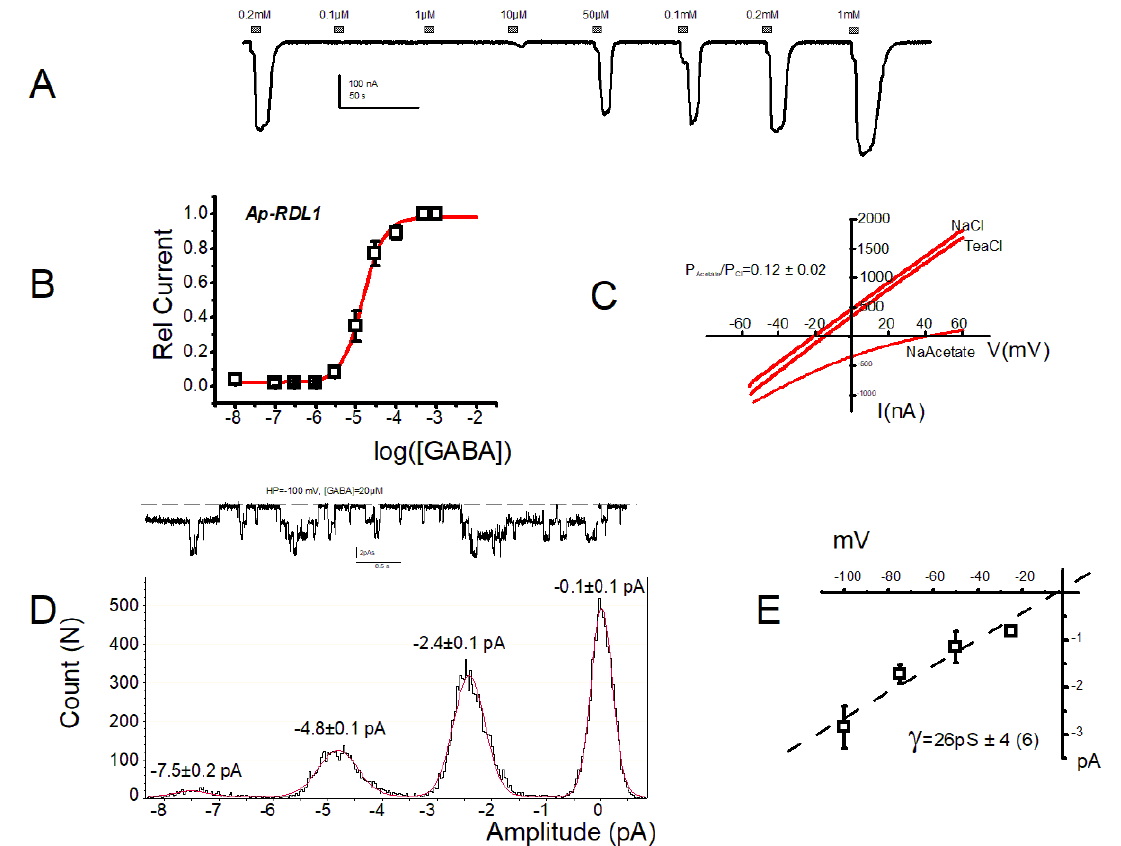
Figure 2. Biophysical characterization of the ( Ap -RDL1 receptor expressed in X laevis oocytes. ( A ) Current trace showing the response of Ap -RDL1 to increasing concentrations of GABA from 0.1 µM to 1 mM at a membrane potential of − 60 mV. ( B ) Full dose – response curve of Ap -RDL1 for GABA. The smooth line represents the best fit to a logistic function. See Table 1 for EC 50 and p values. ( C ) Representative current traces showing the response of the Ap -RDL1 to voltage ramps from − 60 to +60 mV in NaCl, TEACl or Na acetate solutions. The calculated relative permeability Pacetate/Pchloride was 0.12 ± 0.02, n = 6. ( D-top ) Single-channel traces recorded in cell-attached patches of oocytes expressing the RDL1 GABAr subunit. The pipette solution contained ND and GABA at 100 µM, and the external solution was OSO-100 (see methods). Note the presence of (at least) 3 channels under the patch. ( D - bottom ) The amplitude histogram of the trace is shown with the value of the amplitude of each peak deduced from the multi-Gaussian fit (red curve). ( E ) Single-channel current-voltage curve obtained at different voltages from 6 patches as shown in ( D - top ) The single-channel conductance is deduced from a linear regression through the experimental points: 26 ± 4 pS. Table 1. Percentage of identity between the different RDL subunits.